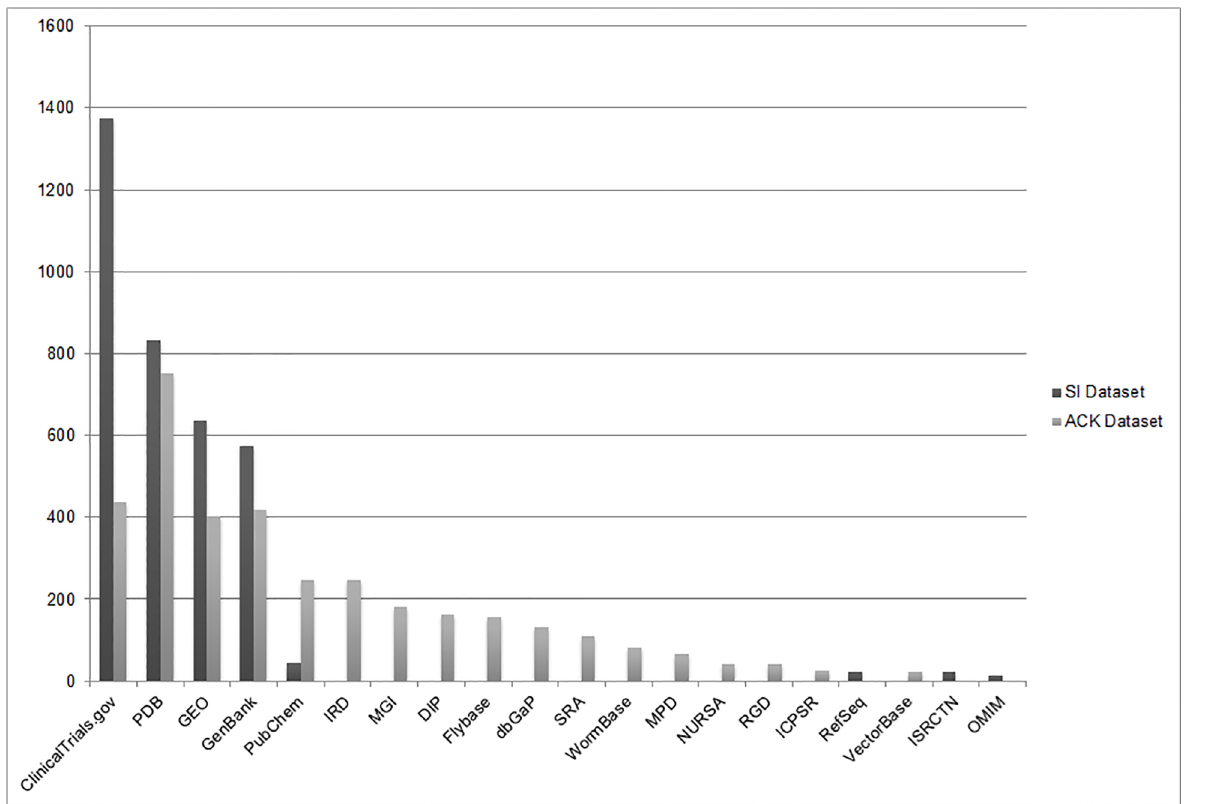
Fig 4. Repositories identified from the PubMed SI field and PMC Acknowledgements where datasets were deposited.